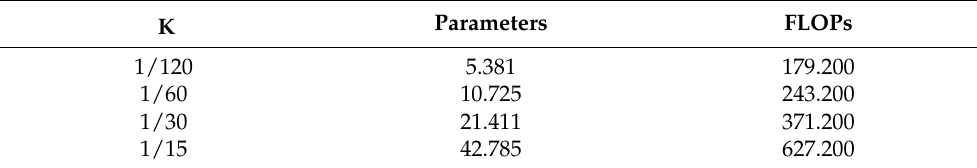
Table 3. Complexity of the encoder in terms of learnable parameters and FLOPs.